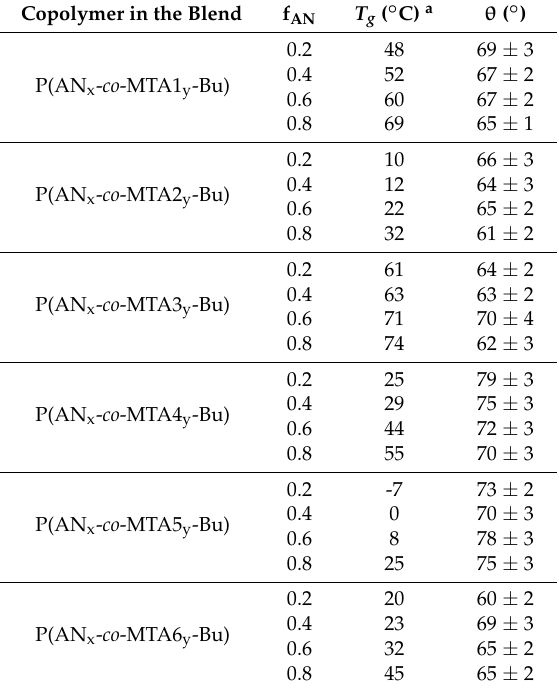
Table 1. Chemical composition of the antimicrobial copolymers used in the blends with PAN, their glass transition temperatures ( T g ), and the static water contact angles ( θ ).